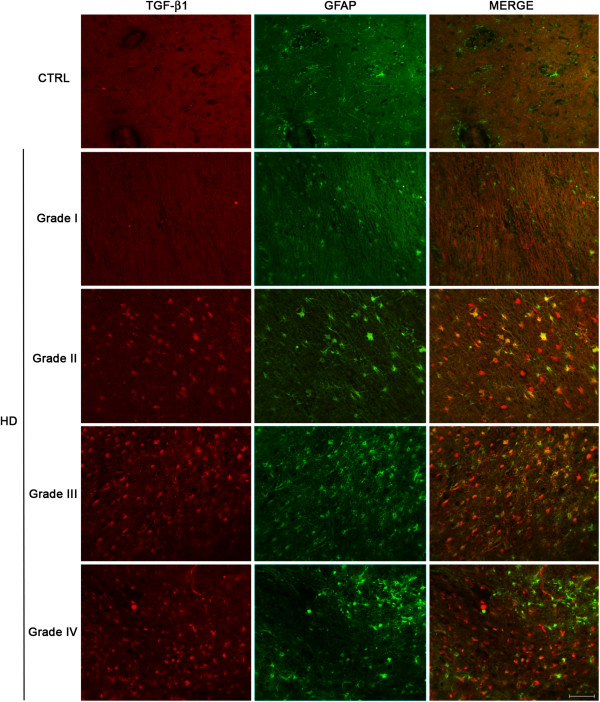
Astrocytes are mainly involved in the synthesis of TGF-β1 in postmortem HD brains. Representative microphotographs of double fluorescent staining for TGF-β1 and GFAP in post-mortem striatal tissues of control subjects and HD patients, showing co-localization between GFAP and TGF-β1 immunoreactive cells at different pathological grades (from II to IV).